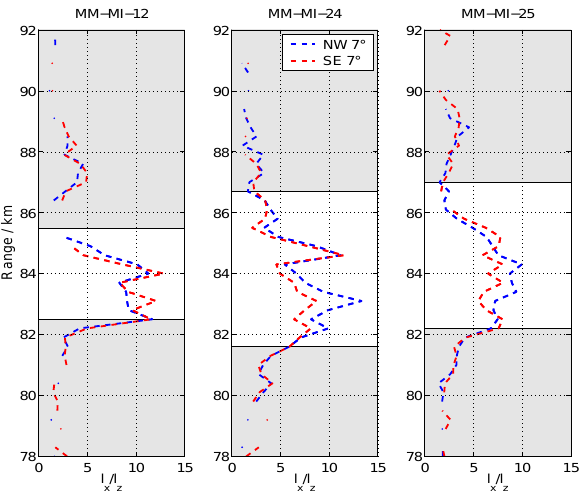
Fig. 7. Observed spectral width (individual values and median pro- files) during the periods of the rocket flights. The dots represent the observed spectral width within the time window of 20min and the median of the individual values used for the estimation of turbulent energy dissipation rates is shown as line. For further consideration only spectral width estimates are shown where the beam broadening ≥ 0m 2 s − 2 correction could be applied and σ 2 turb